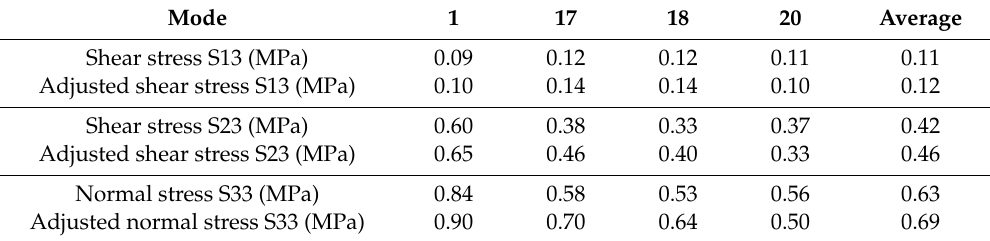
Figure 13. Stress S13 ( a ), S23 ( b ) and S33 ( c ) at bottom of ice layer for mode 17. Table 13. Stress S13, S23 and S33 for delamination modes.